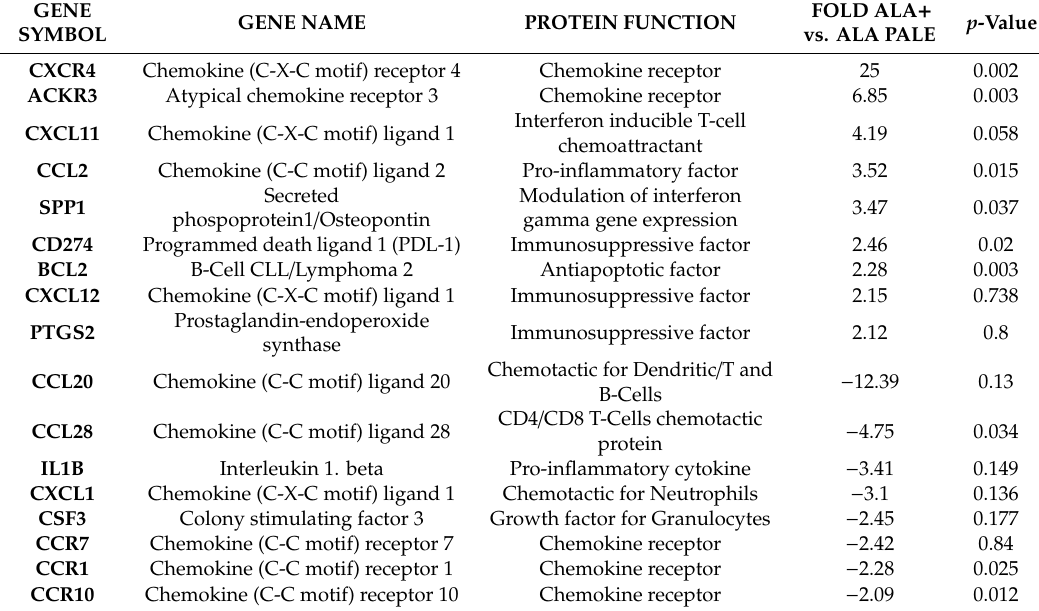
Table 3. Comparison of genes di ff erentially expressed in GASC-ALA + versus GASC-ALA PALE. Table shows genes, with a significant up or down-regulation, in GASC-ALA + compared to GASC-ALA PALE. Values indicate Fold Regulation calculated using the formula (2ˆ ( − Delta-Delta CT)), i.e., the normalized gene expression (2ˆ ( − Delta CT)) in the test sample (GASC-ALA + ) divided by the normalized gene expression (2ˆ ( − Delta CT)) in the control sample (GASC-ALA PALE). p -values are calculated based on a Student’s t-test of the replicate 2ˆ ( − Delta CT) values for each gene in control and treatment groups.